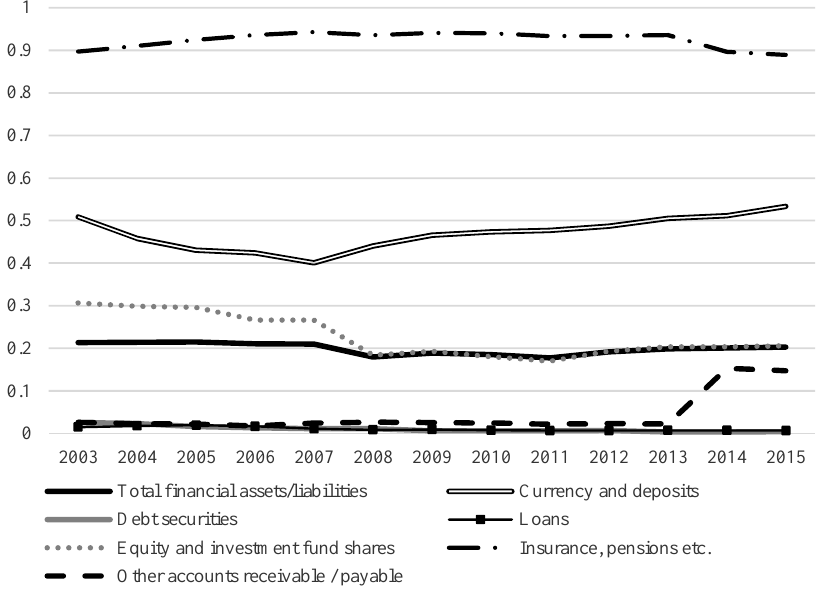
Figure 5. The role of the household sector in the financing of various forms of debt